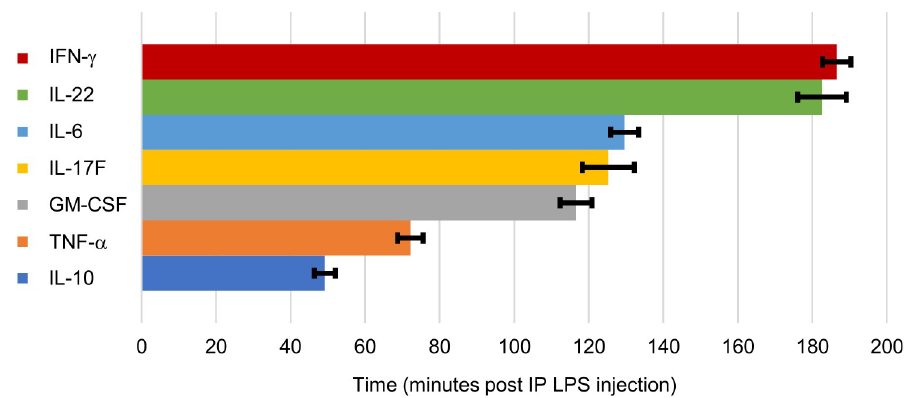
Fig 4. Mean starting times of cytokine elevations. Based on 5% of maximum elevation after IP injection of LPS (5 mg/kg). Error bars, s.e.m.